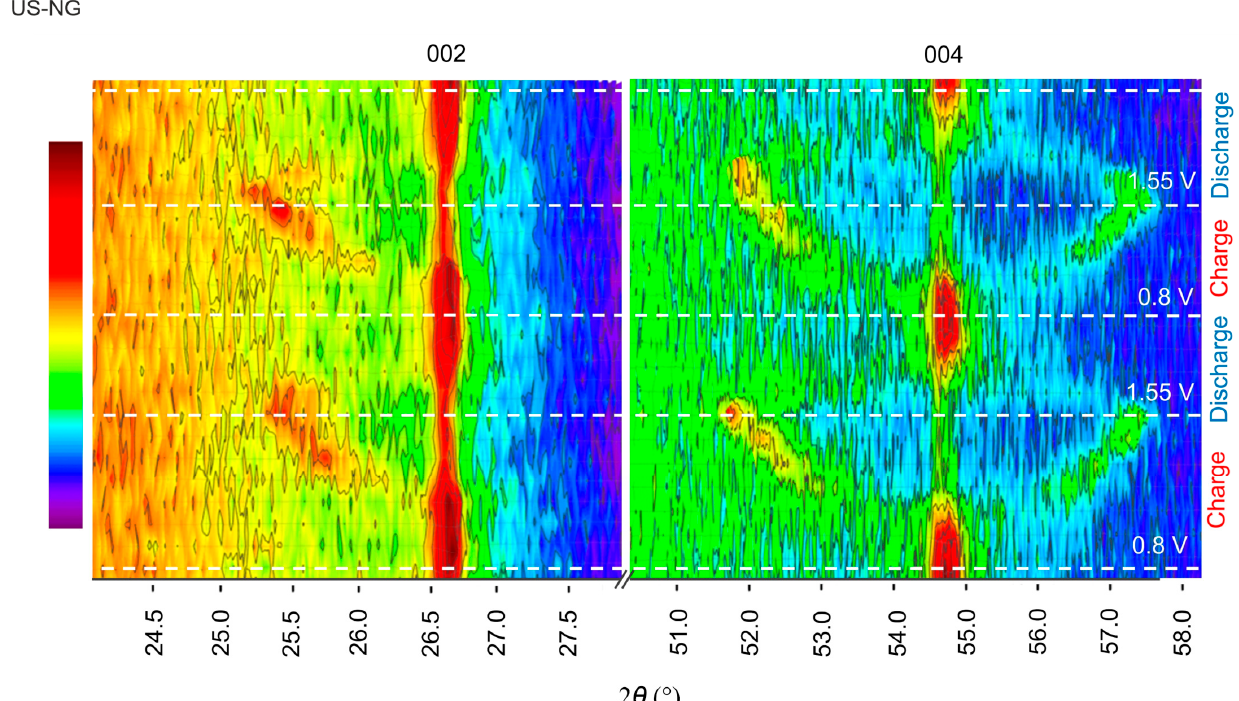
Figure 4. Operando XRD analysis of US ‐ NG during charge/discharge process in 2.4 M Al(ClO 4 ) 3 aqueous electrolyte solution.